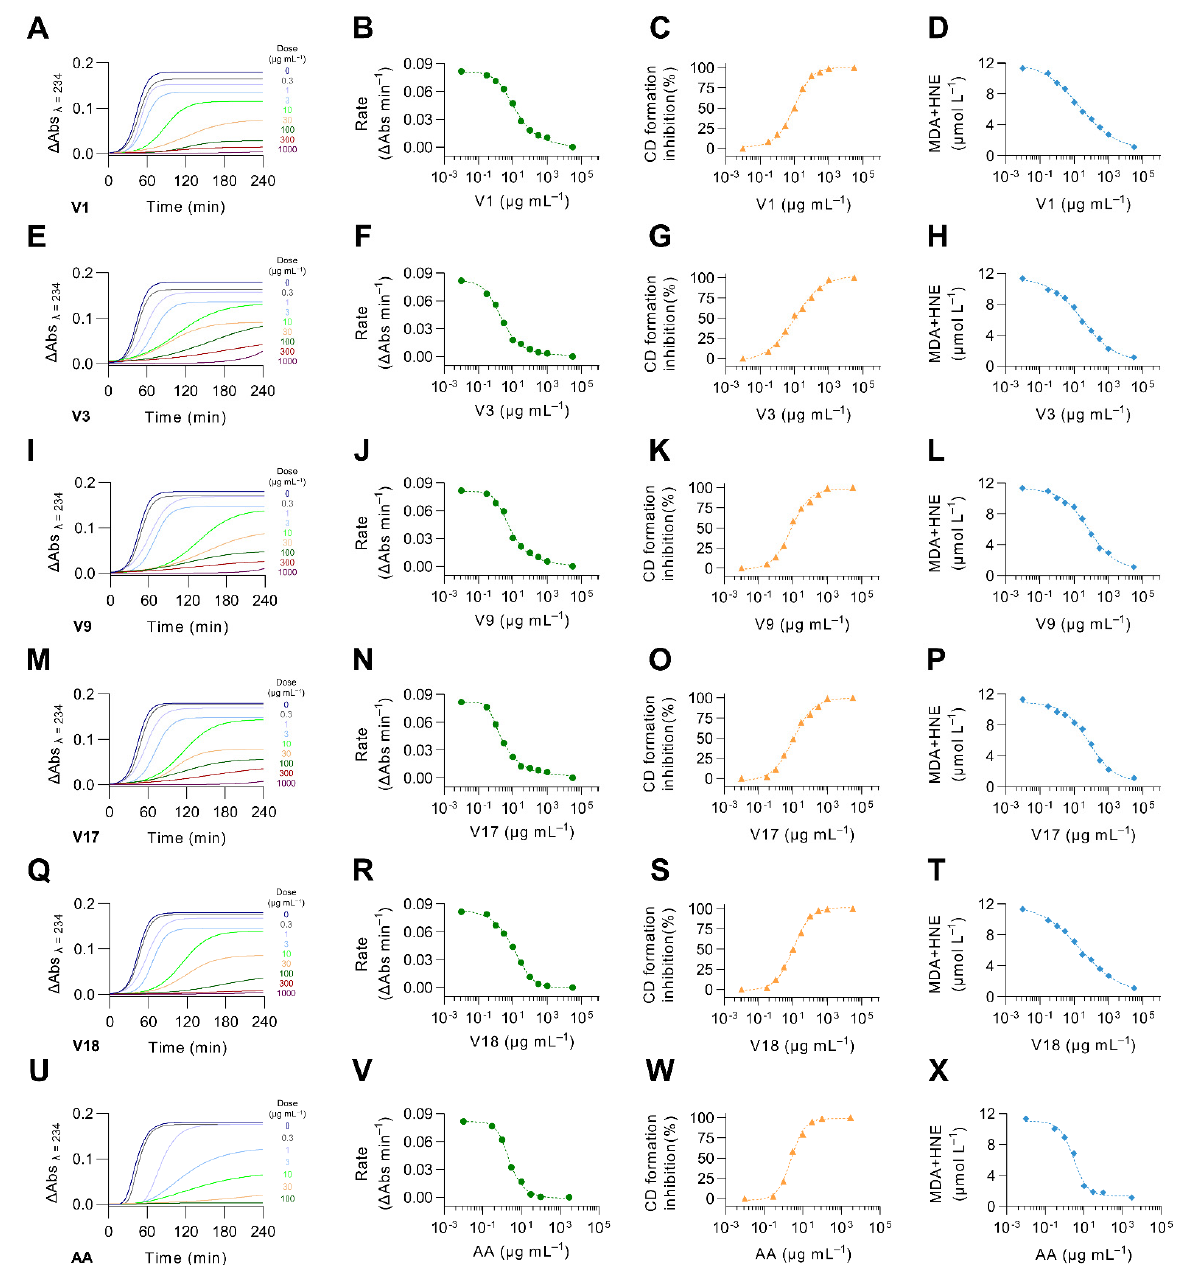
Figure 9. Effect of selected soybean digests (V1, V3, V9, V17, and V18 at 0.3–1000 µ g protein mL − 1 ) and ascorbic acid (AA, 0.3–1000 µ g mL − 1 ) on LDL oxidation markers: kinetic changes in absorbance at 234 nm (0–240 min), rate constant of the reaction propagation (K, ∆ Abs min − 1 ), and the formation of conjugated dienes (CD, % inhibition relative to control), malondialdehyde and 4-hydroxynonenal (MDA+HNE, µ mol L − 1 ). Panels ( A – D , E – H , I – L , M – P , Q – T , U – X ) correspond to LDL oxidation mark- ers of soybean varieties V1, V3, V9, V17, V18, and ascorbic acid, respectively. Results are reported as mean ± SD ( n = 3). Bars with different letters significantly differ according to ANOVA and Tukey’s multiple range test ( p <